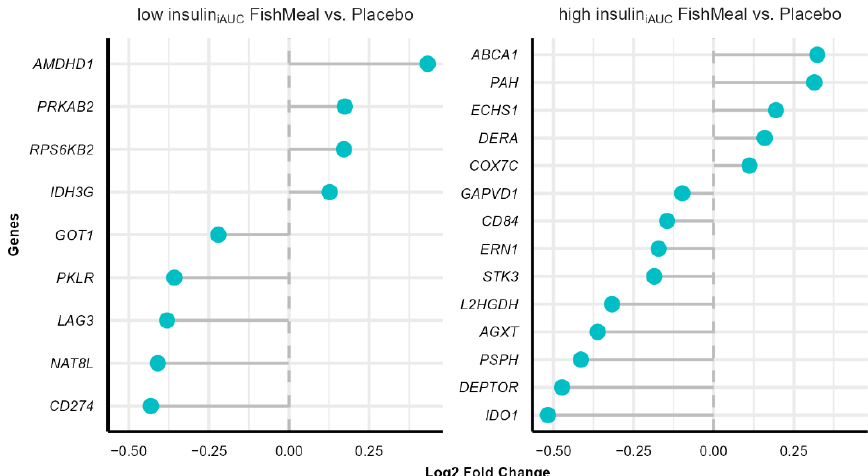
Figure 5. Differentially expressed genes in the low insulin iAUC and high insulin iAUC groups after the intervention. The figure shows the differentially expressed genes ( p value < 0.05, no FDR correction) after the intervention in the low insulin iAUC and high insulin iAUC groups, sorted by fold change (blue dots). The genes with altered expression were obtained using a linear model adjusted for covariates (age, sex, BMI, and daily use of tobacco). Fold change represent the difference in PBMCs gene expression between fish protein-treated low insulin iAUC and placebo-treated low insulin iAUC group ( left panel ) and the difference between fish protein-treated high insulin iAUC and placebo-treated high insulin iAUC ( right panel ). Abbreviations: ABCA1 : ATP binding cassette subfamily A member 1, AGXT : alanine-glyoxylate and serine-pyruvate aminotransferase, AMDHD1 : amidohydrolase domain containing 1, CD274 : CD274 molecule, CD84 : CD84 molecule, COX7C : cytochrome c oxidase subunit 7C, DEPTOR : DEP domain containing MTOR interacting protein, DERA : deoxyribose-